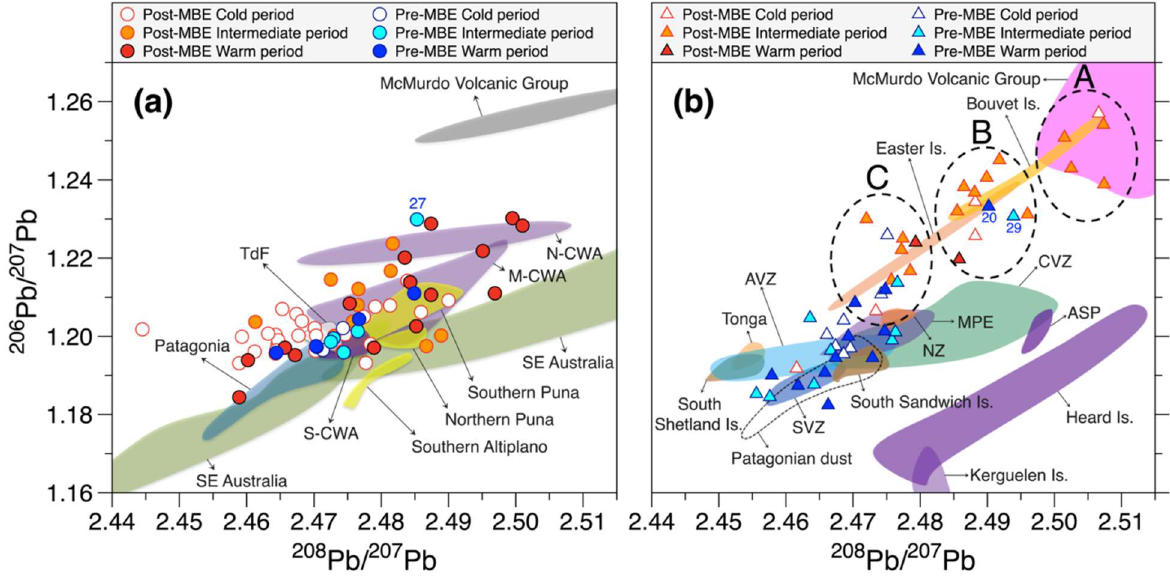
Figure 2. A plot of 206 Pb/ 207 Pb versus 208 Pb/ 207 Pb in the EDC ice core. Also included are post-MBE data previously reported from the EDC ice core [17]. The observed data are divided into isotopic compositions for ( a ) dust-dominant samples with a dust-derived Pb fraction of >60% and ( b ) non-dust dominant samples with a dust-derive Pb fraction of <60% (see text). The isotopic fields of the potential sources of dust in ( a ) and volcanic Pb in ( b ) were derived from the literature: Puna-Altiplano Plateau (PAP) [18], central-western Argentina (CWA) [18], Patagonia/Tierra del Fuego (TdF) [18], southeastern (SE) Australia (Murray-Darling Basin) [17,34], McMurdo Volcanic Group (McM) [35,36], South Sandwich Island [37], South Shetland Island [38], Bouvet Island [39], New Zealand (NZ) [40], Easter Island and Tonga [39], Marion and Prince Edward (MPE) [41], Kerguelen Island [42], Heard Island [43], Amsterdam-St. Paul Island (ASP) [44], SVZ: Southern Volcanic Zone, and AVZ: Austral Volcanic Zone of the Andean Volcanic Belt [45,46]. Group A, B, and C within the dashed circles in Figure 2b exhibit stepwise changes in the post-MBE isotopic compositions to more radiogenic values as progressive reduction in the mean proportions of dust-derived Pb (29 ± 13% for group A, 42 ± 11% for group B, and 51 ± 6% for group C). Sample numbers mentioned in the text are also shown in Figure 2. The acronyms next to the fields are defined in Figures S2 and S3. A different situation emerges for the isotopic compositions during intermediate and warm climatic conditions before and after the MBE. The post-MBE isotopic signatures during intermediate climatic stages are characterized by a significant variation in the ra- tios of 206 Pb/ 207 Pb, moving to the M-CWA and northern CWA (N-CWA) fields, excluding two data points within the southeastern Australian field (Figure 2a). The pre-MBE iso- topes remain within a small range as in the cold climates with the exclusion of sample no. 27 (Figure 2a), for which all elemental concentrations are relatively high compared to those observed during the corresponding climatic conditions (Figure S5), reflecting a strong influence of volcanic emissions. Subsequently, the post-MBE warm interglacial iso- topes vary over a wider range of the mixing line between Patagonia and the McMurdo Volcanic Group (MVG) in northern Victoria Land, Antarctica. The pre-MBE interglacial data also fall on a post-MBE compositional area. The Pb isotopic signatures in the EDC ice moving towards the most radiogenic composition have been attributed to increased vol- canic contributions from the MVG [17,18]. However, the dust fractions of the correspond- ing samples do not show any systematic changes with changing climate before and after